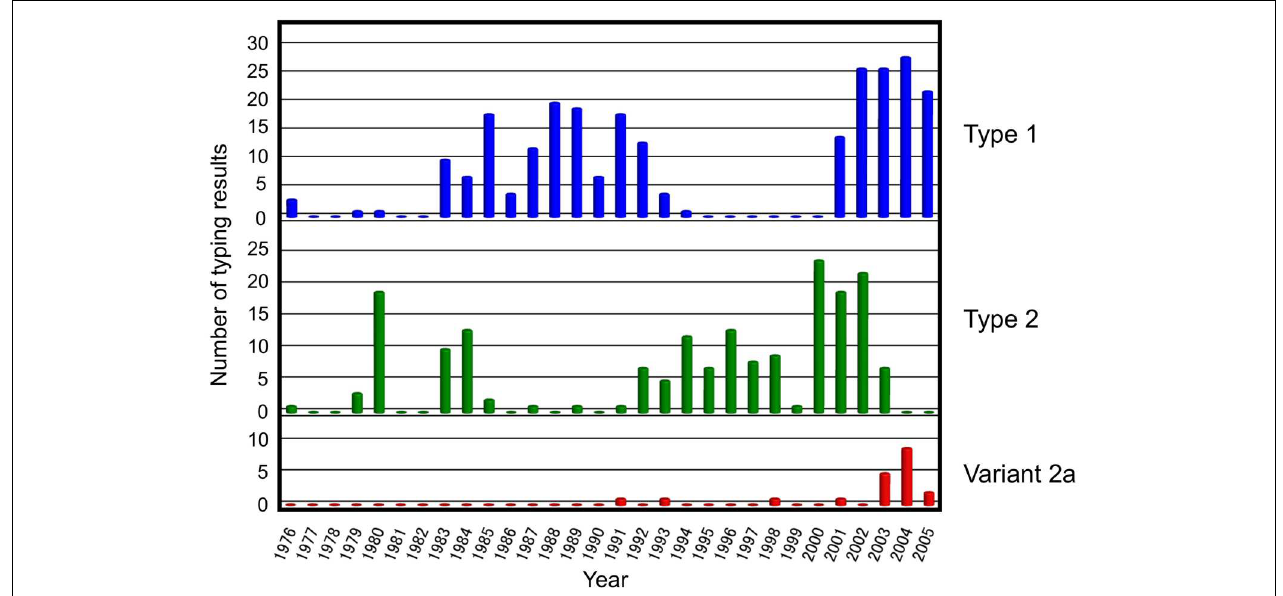
FIGURE 4 | Typing analysis of the M. pneumoniae p1 gene from isolates detected in Japan between 1976 and 2005. The majority of M. pneumoniae strains and clinical specimens included in this analysis were collected in the Kanagawa prefecture. Figure adapted from Kenri et al.